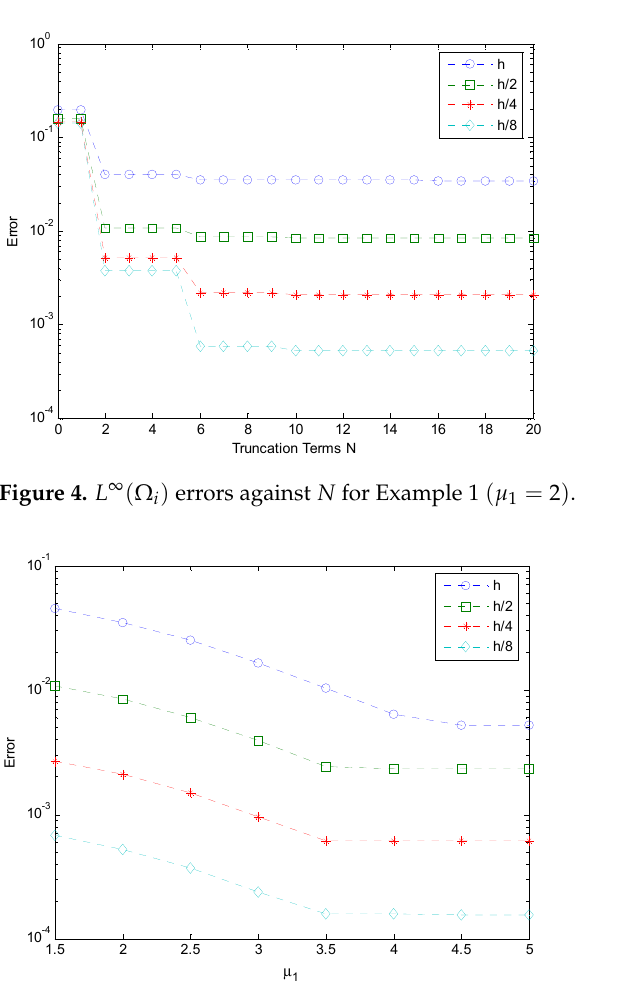
Figure 4. 𝐿 (cid:2998) (Ω (cid:3036) ) errors against 𝑁 for Example 1 (𝜇 (cid:2869) = 2) .